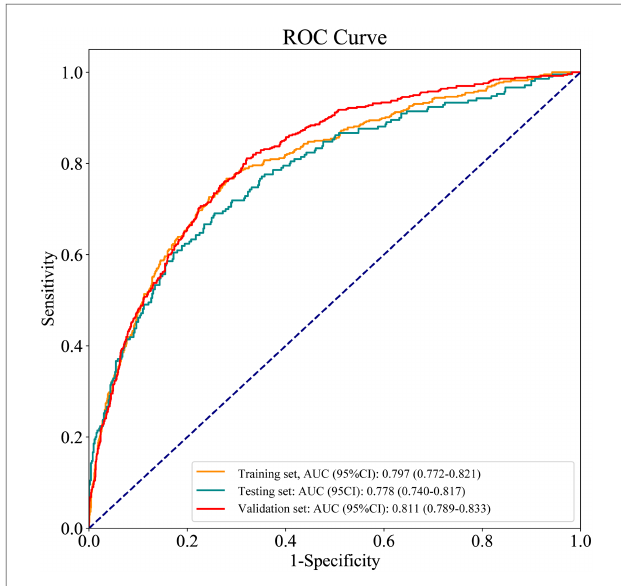
FIGURE 3 ROC curves for the prediction model in the training set, testing set and validation set.